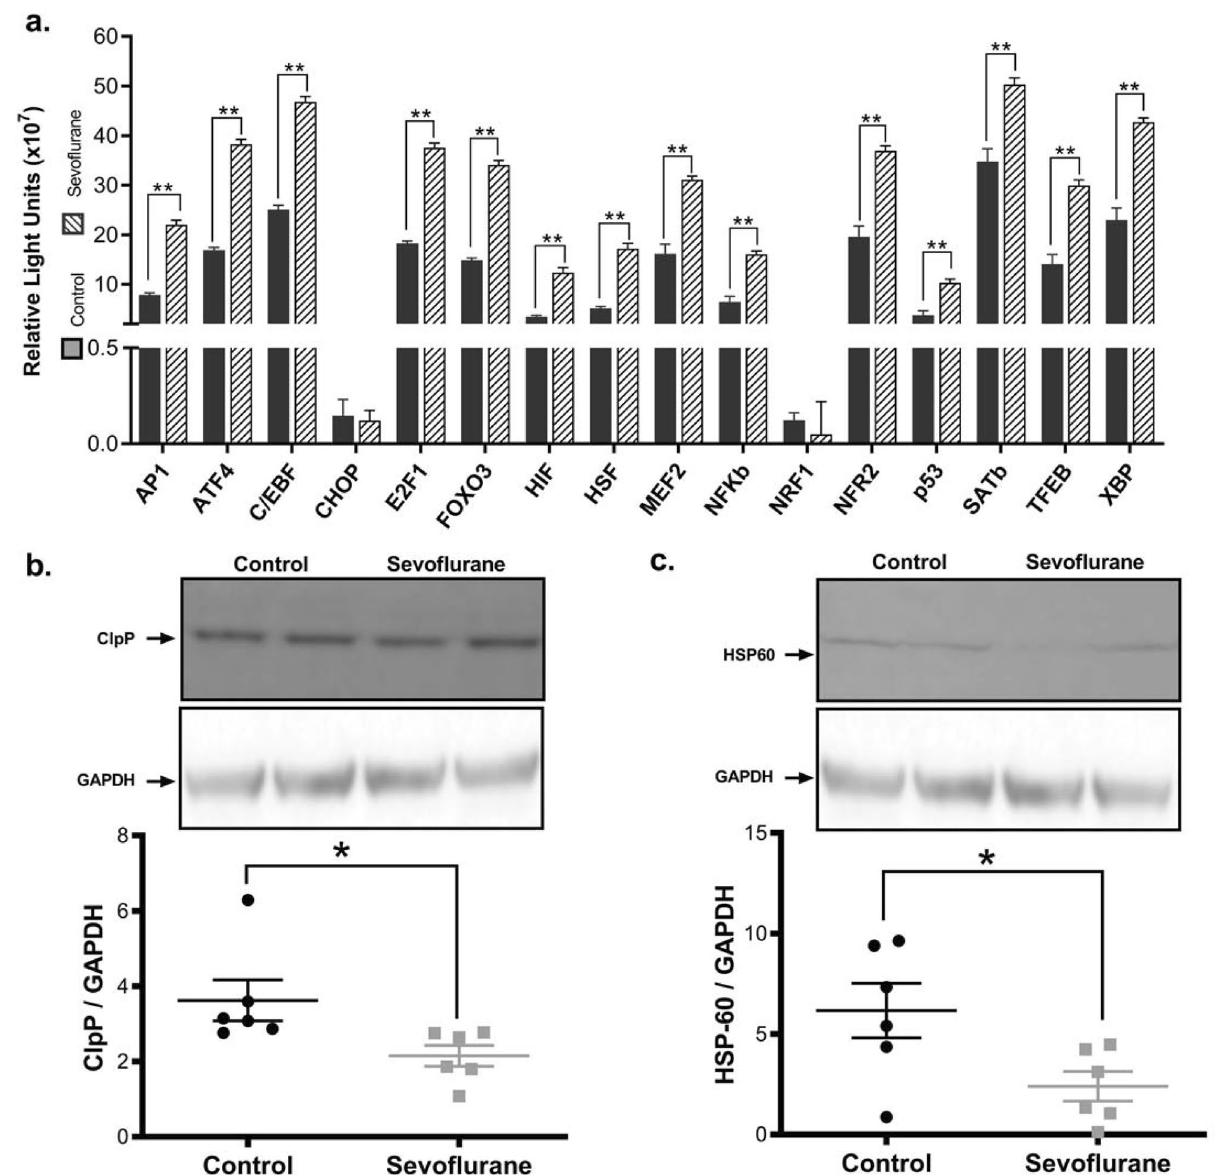
Figure 6. Sevoflurane exposure induces persistent alterations to the mitochondrial unfolded protein response (mtUPR). Quantification of nuclear-localized transcription factors reveals an increase in those responsible for mitochondrial stress response and mtUPR pathways after infant sevoflurane exposure (dashed bars), relative to non-exposed animals (black bars) ( a ). The observed changes in transcription factors were reflected in the levels of enzymes involved in the mitochondrial protein quality control (ClpP) ( b ) and folding (HSP-60) ( c ). Values represent means ± SEM, with 6 animals in each group. Statistical significance between groups indicated with (*) for p -value < 0.05, and (**) for p- value <